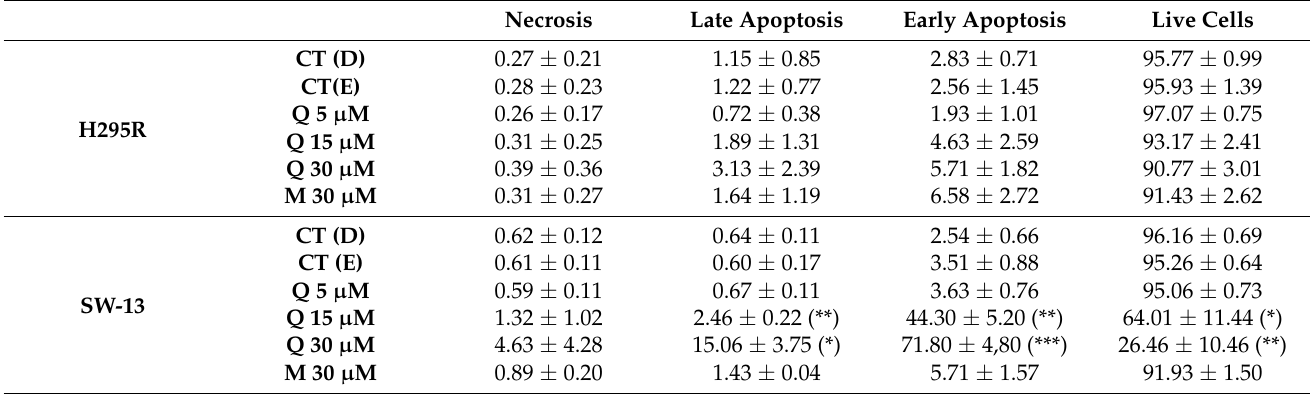
Figure 6. Quercetin and mitotane exerts different effects on proliferation rates after 48 h of treatment. ( A ) Representative images of H295R cells on both controls and treated with 30 µ M of quercetin and mitotane; ( B ) representative images of SW-13 cells on both controls and treated with 30 µ M of quercetin and mitotane; ( C ) percentage of Ki67-positive cells for H295R cells; ( D ) percentage of Ki67-positive cells for SW-13 cells. * ( p < 0.05); ** ( p < 0.005); *** ( p < 0.0005) in comparison with respective controls. Table 3. Percentage of Annexin V and 7-AAD staining on H295R and SW-13